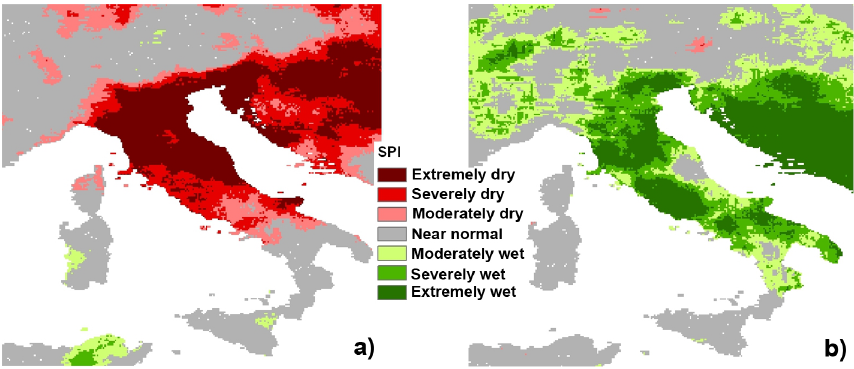
Figure 3. Examples of SPI (Standardized Precipitation Index) maps for the Italian area: ( a ) SPI 12 of July 2012; ( b ) SPI 3 of July